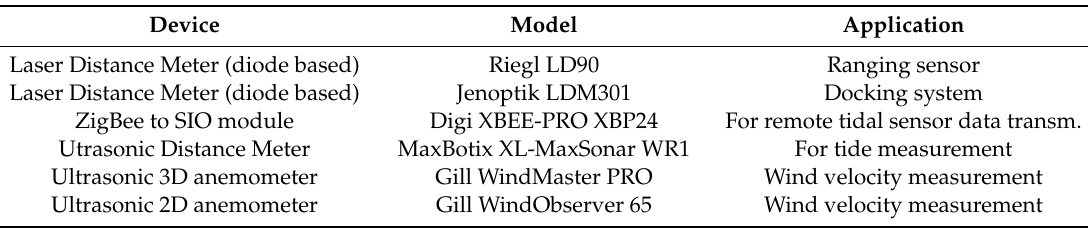
Table 3. Comparison of methods.